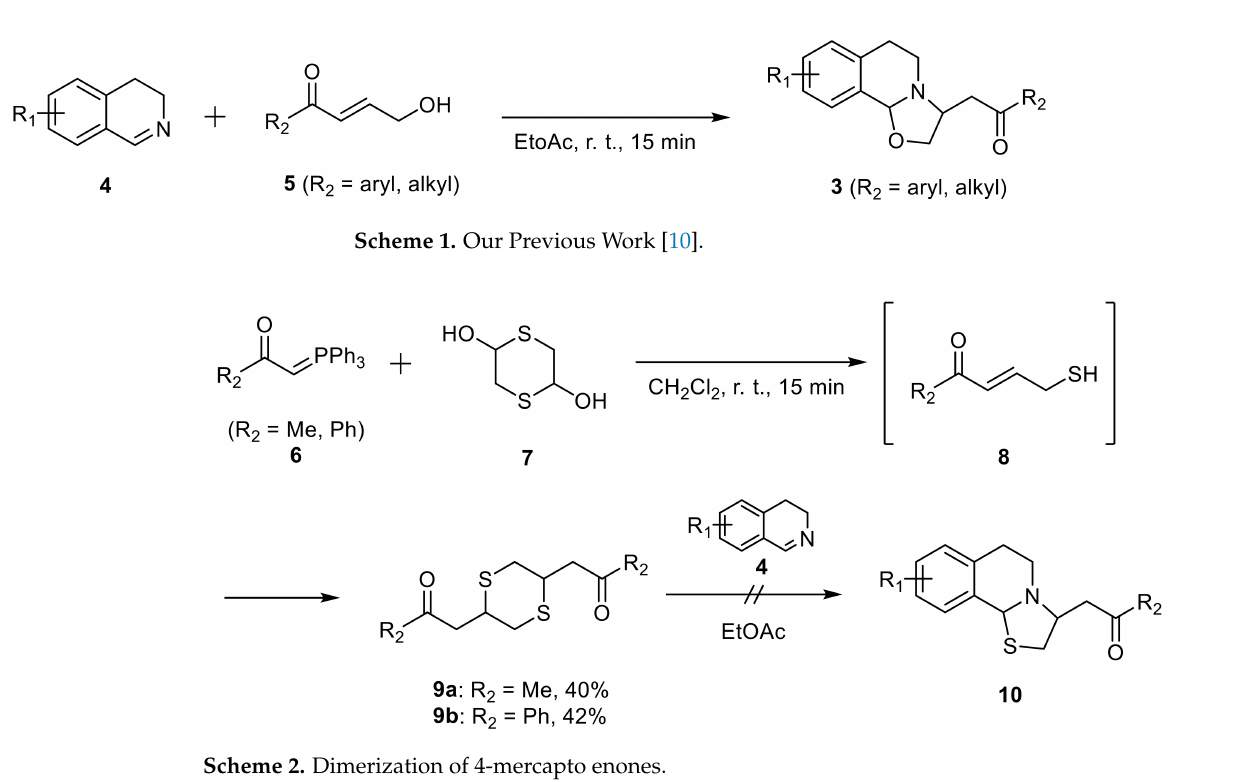
Scheme 2. Dimerization of 4-mercapto